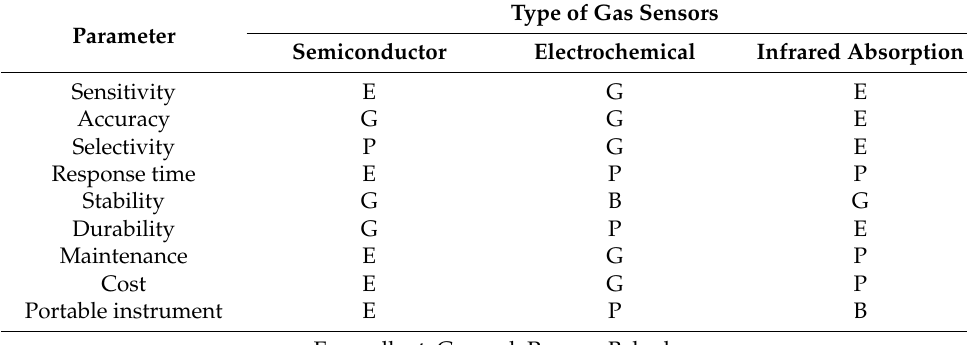
Table 1. Comparison of various types of gas sensors [29,89].